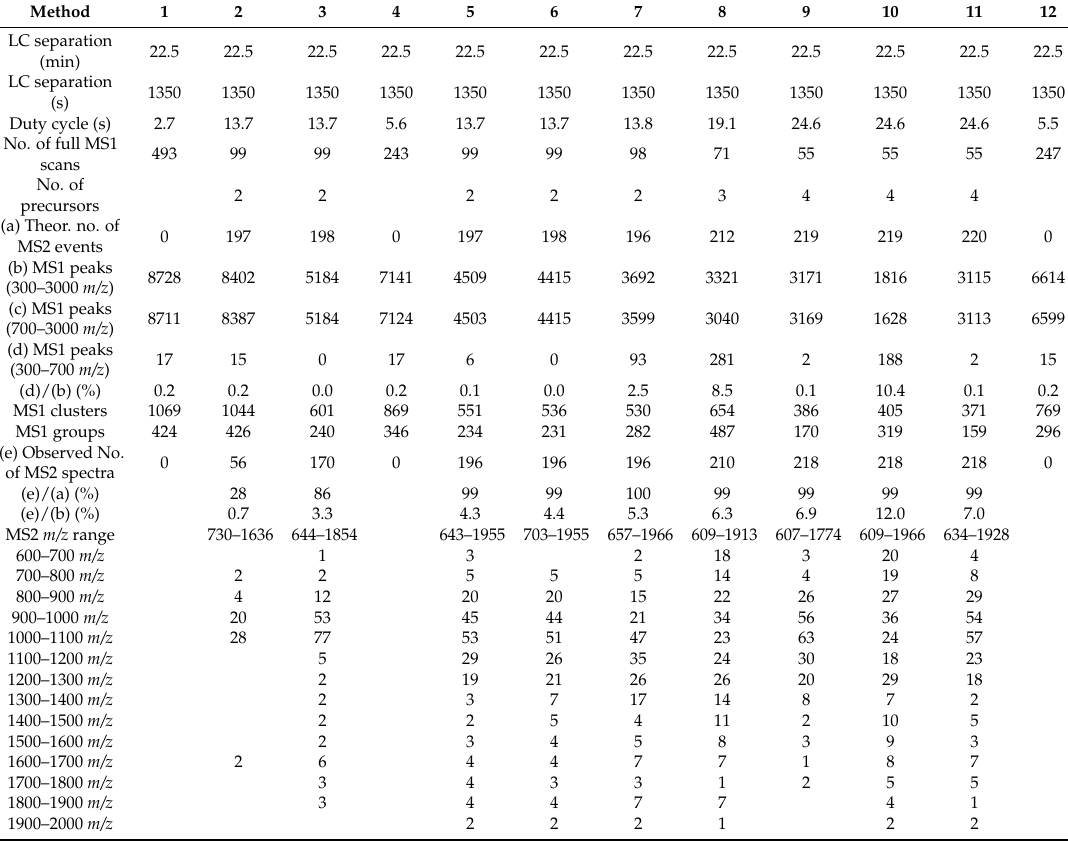
Table 2 compares all 12 methods based on LC-MS and LC-MS/MS observations Table 2. Number of spectral peaks, clusters, groups and MS/MS spectra found in the mixed standard sample across all 12 methods using Genedata Refiner